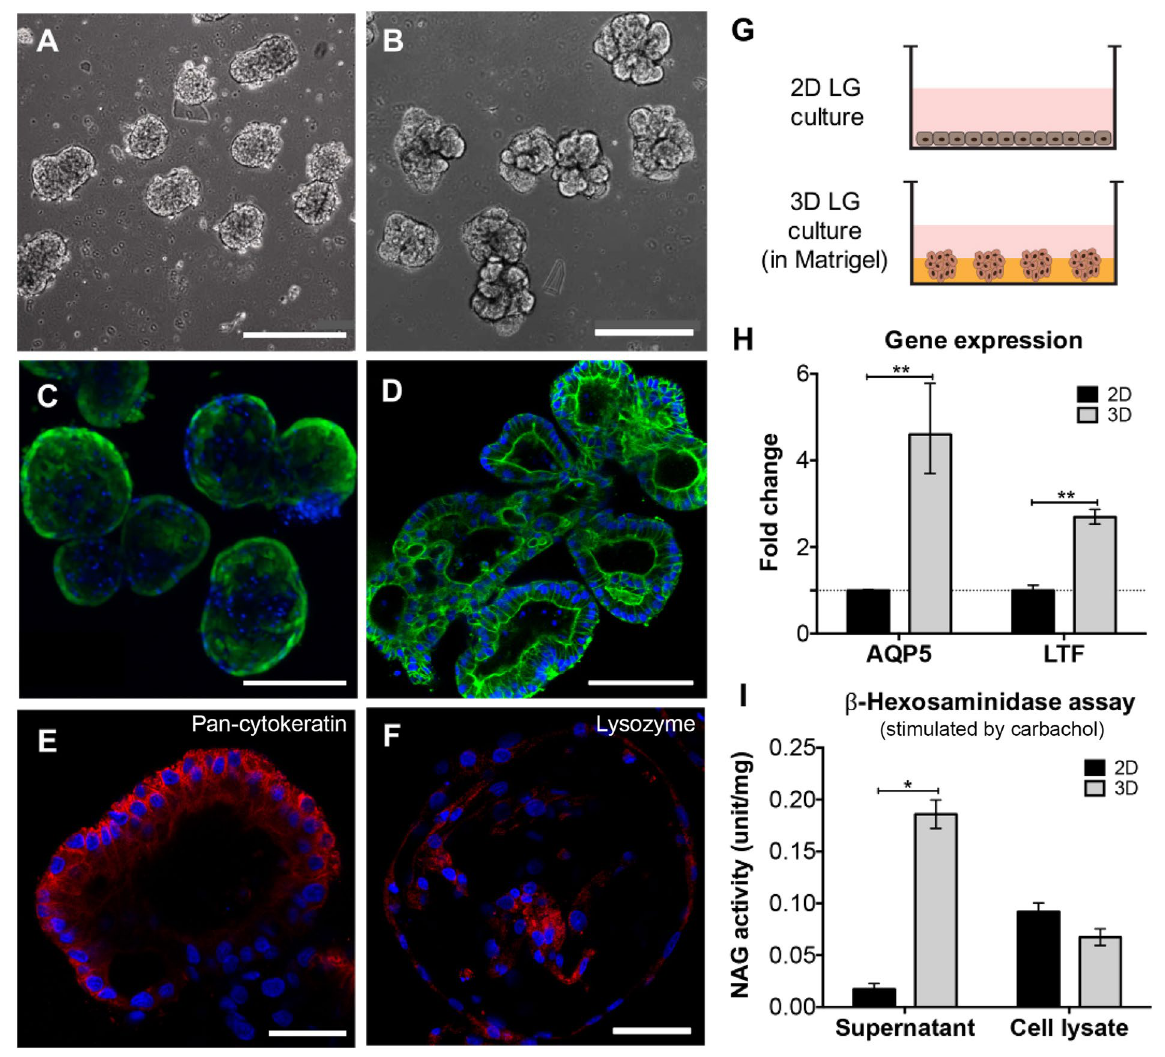
Figure 3. 3D lacrimal gland (LG) cell spheroids formation and culture. ( A – D ) Phase contrast and F-actin staining (Phalloidin) images of LG cell spheroids in Matrigel at different stages. ( A , C ) day 2; ( B , D ) day 5. ( E , F ) IHC showing the expression of LG specific markers (red; counterstained by DAPI). ( E ) Pan-cytokeratin; ( F ) lysozyme. Scale bar: 400 μ m ( A , B ); 200 μ m ( C ); 100 μ m ( D ); 50 μ m ( E , F ). ( G ) Schematics of LG cultured as either 2D monolayer or 3D spheroids embedded in Matrigel. ( H ) Gene expression (RT-qPCR; fold change is expressed as 2 −ΔΔ CT ) and ( I ) β -hexosaminidase assay comparing LG cells culture under 2D and 3D conditions. Both supernatant and cell lysate were collected for hexosaminidase assay and the value (units) was normalized to total protein content (mg). * p < 0.05; ** p <